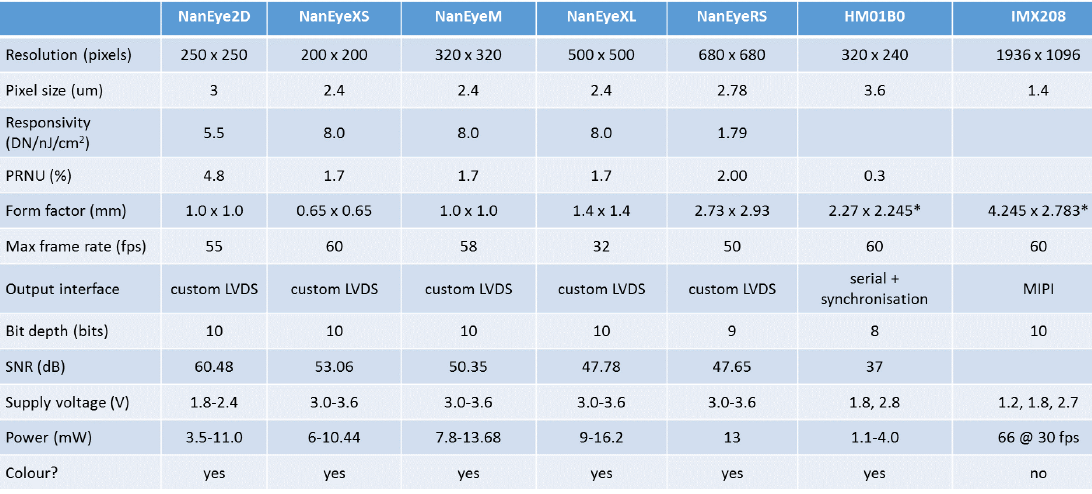
Figure 8. Cameras supported by